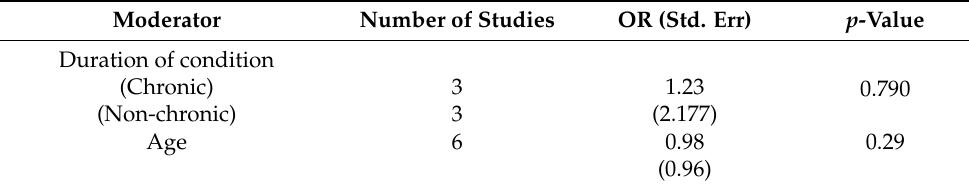
Table 2. Meta-regression results on categorical Table 2. Meta ‐ regression results on categorical moderators.